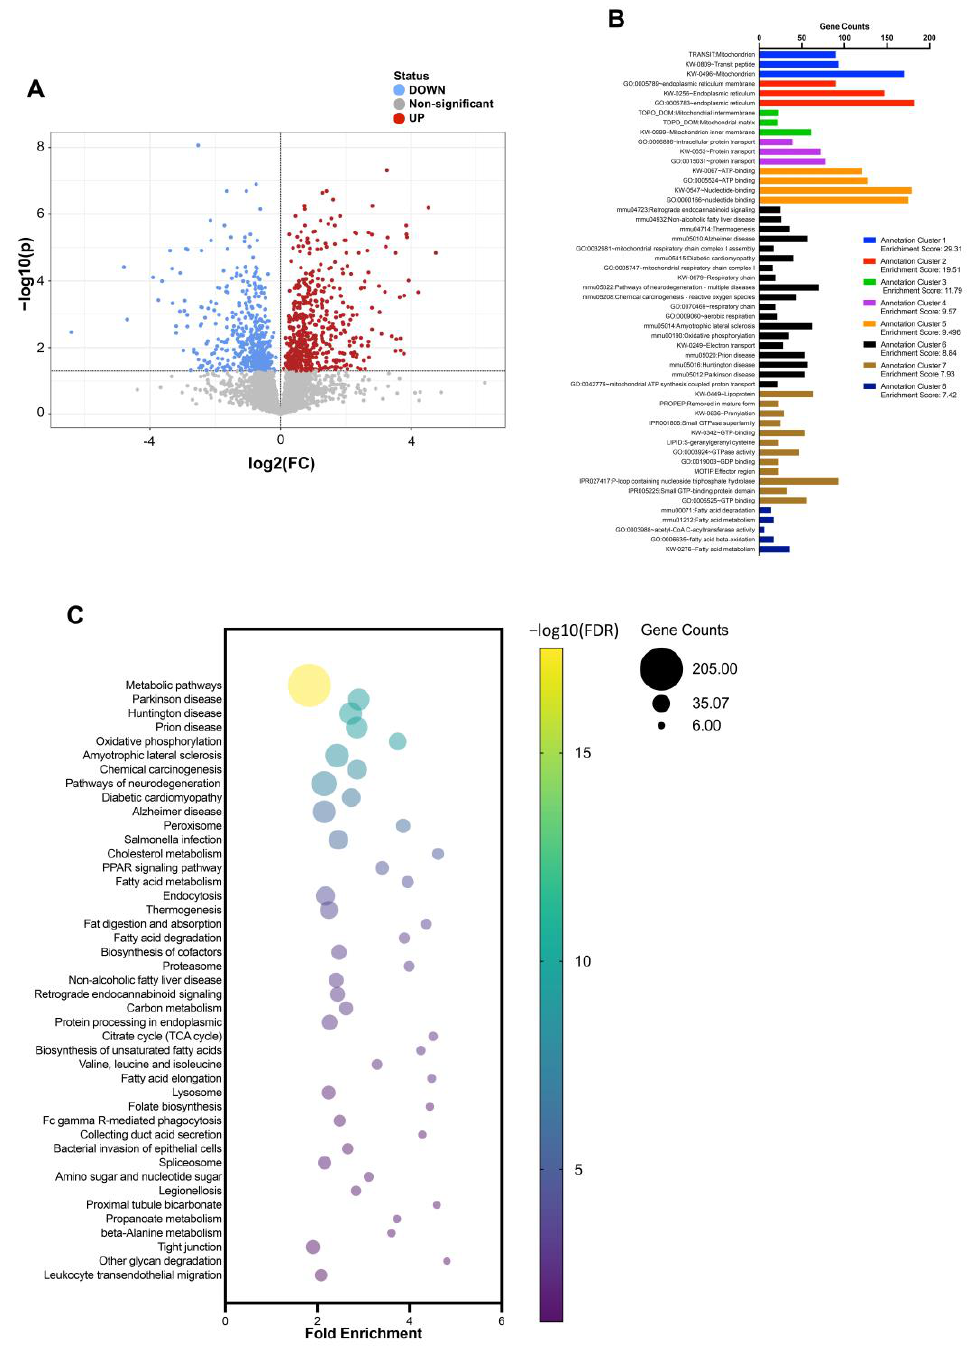
Figure 5. High-throughput deep proteomics of IECs from the upper small intestine of HFD- and CD-fed mice. ( A ) Volcano plot of differentially expressed proteins (DEPs). Red and blue dots represent upregulated and downregulated proteins, respectively. ( B ) Functional annotation clustering of DEPs by DAVID. ( C ) Kyoto Encyclopedia of Genes and Genomes (KEGG) pathway enrichment of DEPs.